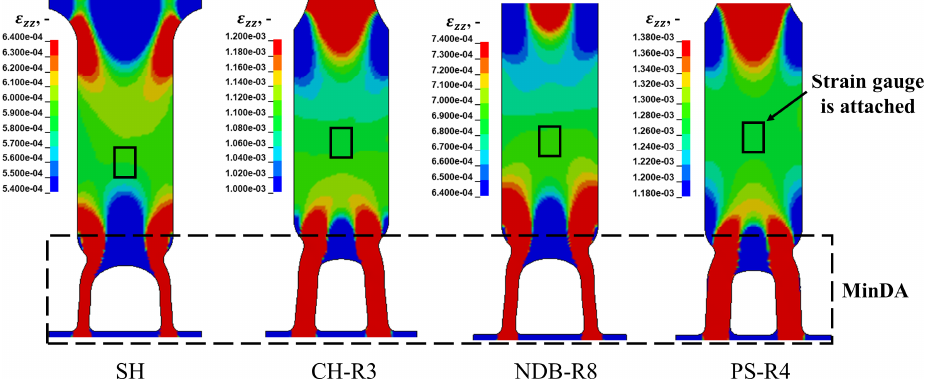
Fig. 2. Strain distribution pattern of different specimens before the onset of